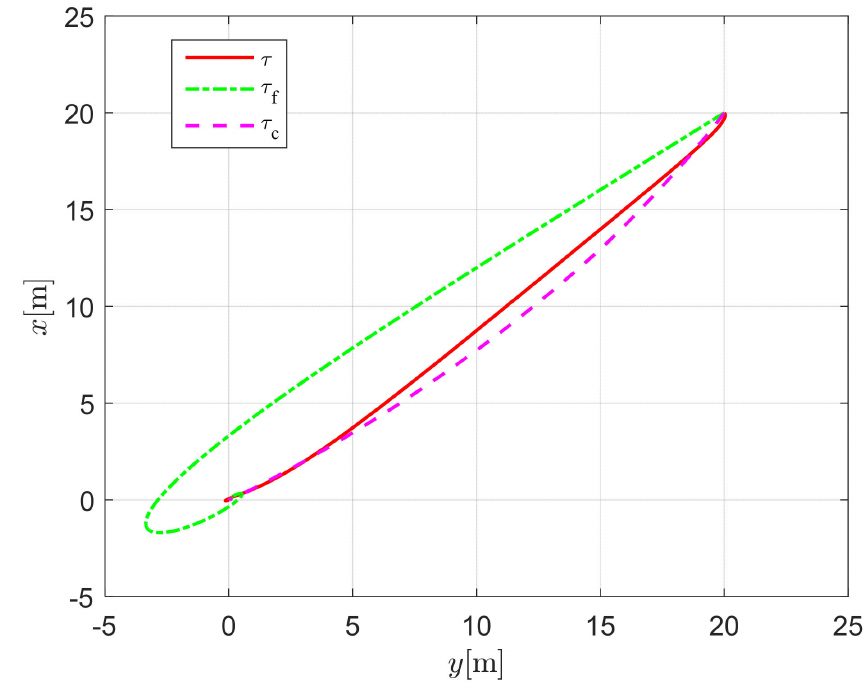
Figure 10. The time response curves of positioning error in Case